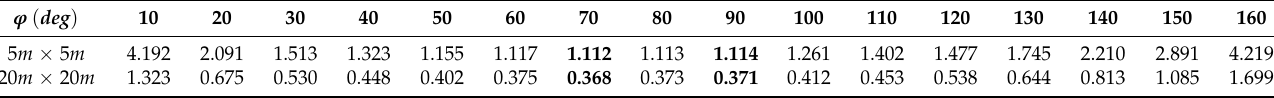
Table 2. The 2D RMSPE ∆ p (m) with varying ϕ in the 5 m × 5 m and 20 m × 20 m environments for the NLOS condition.